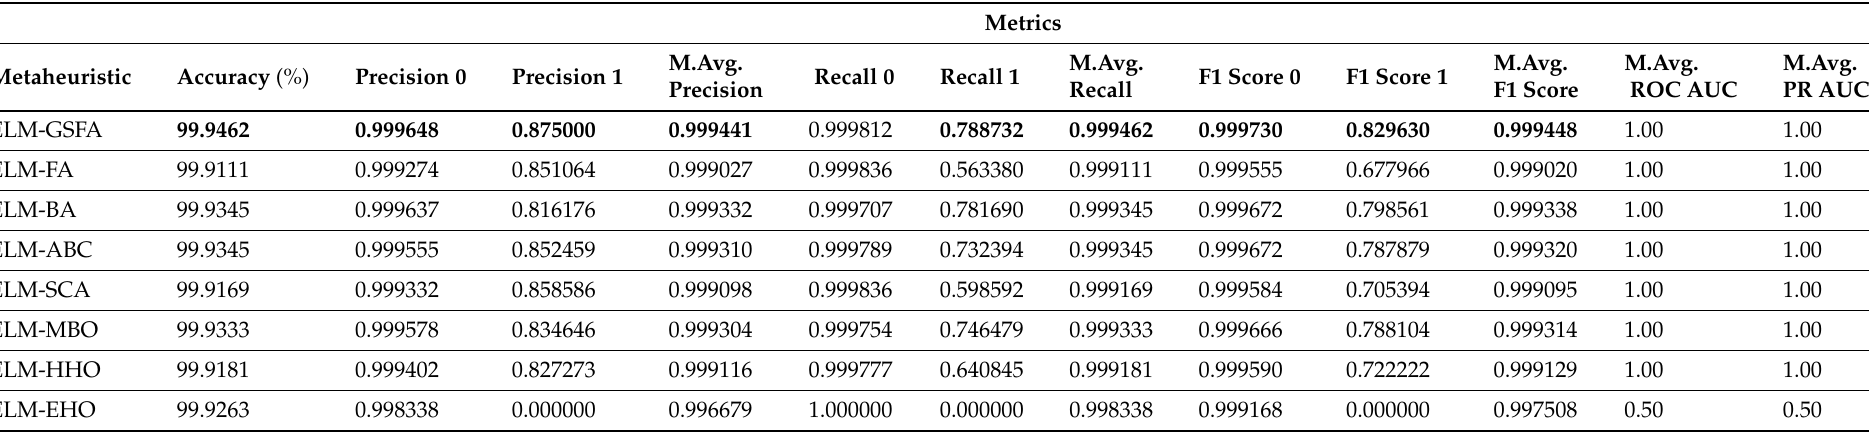
Table 9. ELM Credit Card Fraud NO SMOTE—detailed